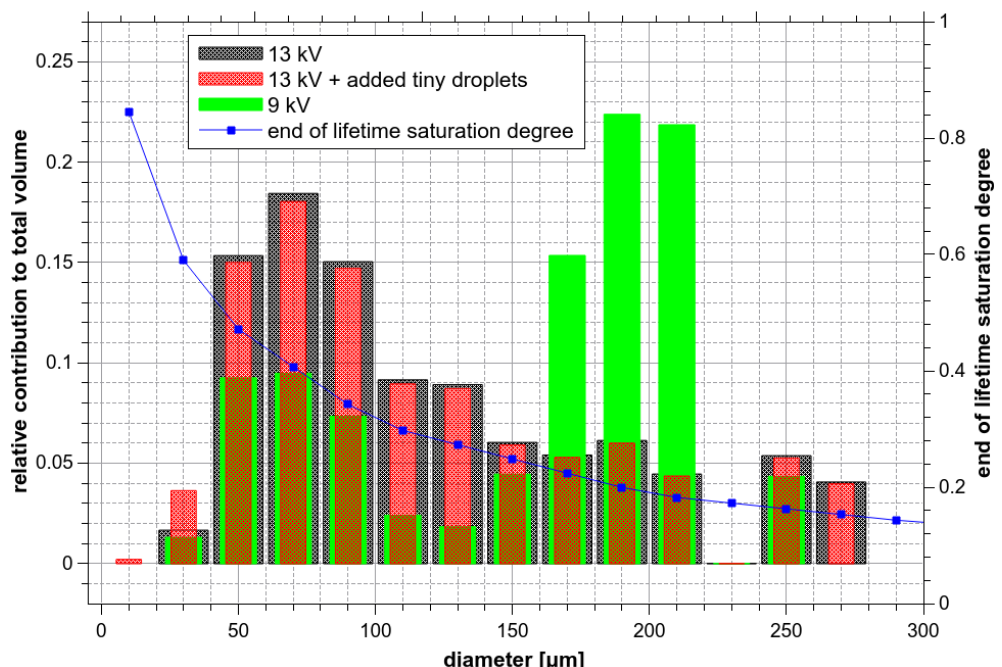
Figure 13. Relative contribution of the droplets with different diameters to the total volume P v (d k ) and saturation degree at the end of their lifetime ξ fin ( d k ) as a function of droplet diameter, V a = 9 and 13 kV, Q w = 300 µL/min .